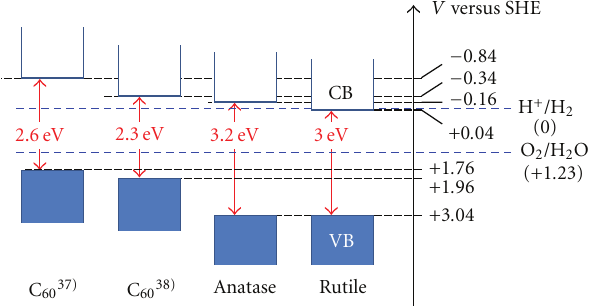
Scheme 1: Schematic illustrations of the band structures of the anatase, rutile, and C 60 .